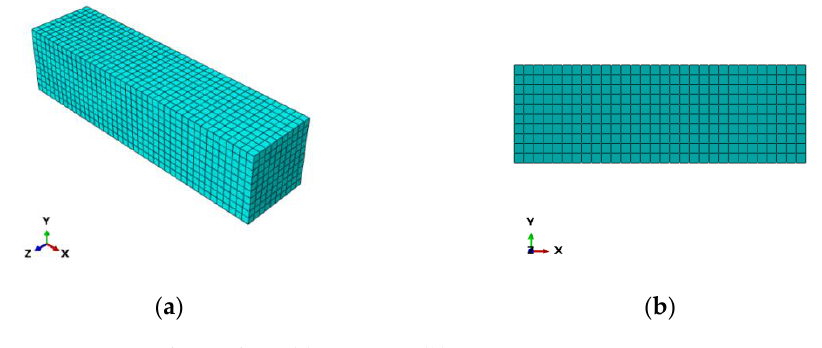
Figure 36. Mesh Dividing: ( a ) Concrete; ( b ) CFRP.